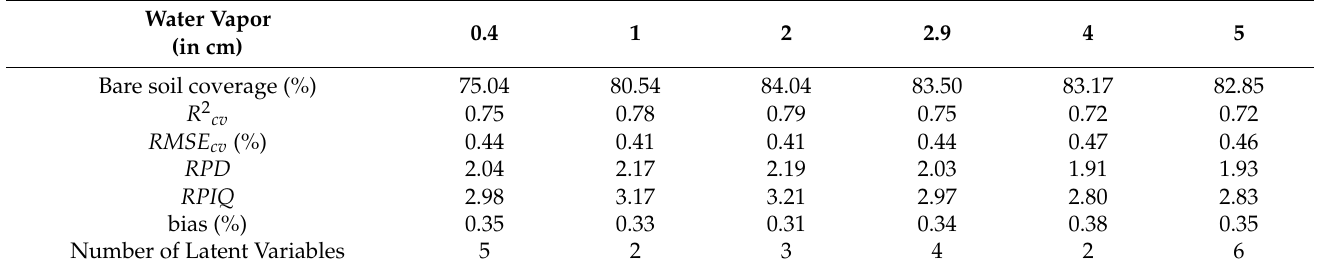
Table 5. Figures of merit obtained from PLSR models, based on Hyperion data corrected by the ATCOR method, and depending on 6 values of WV. The best performances are highlighted in bold.